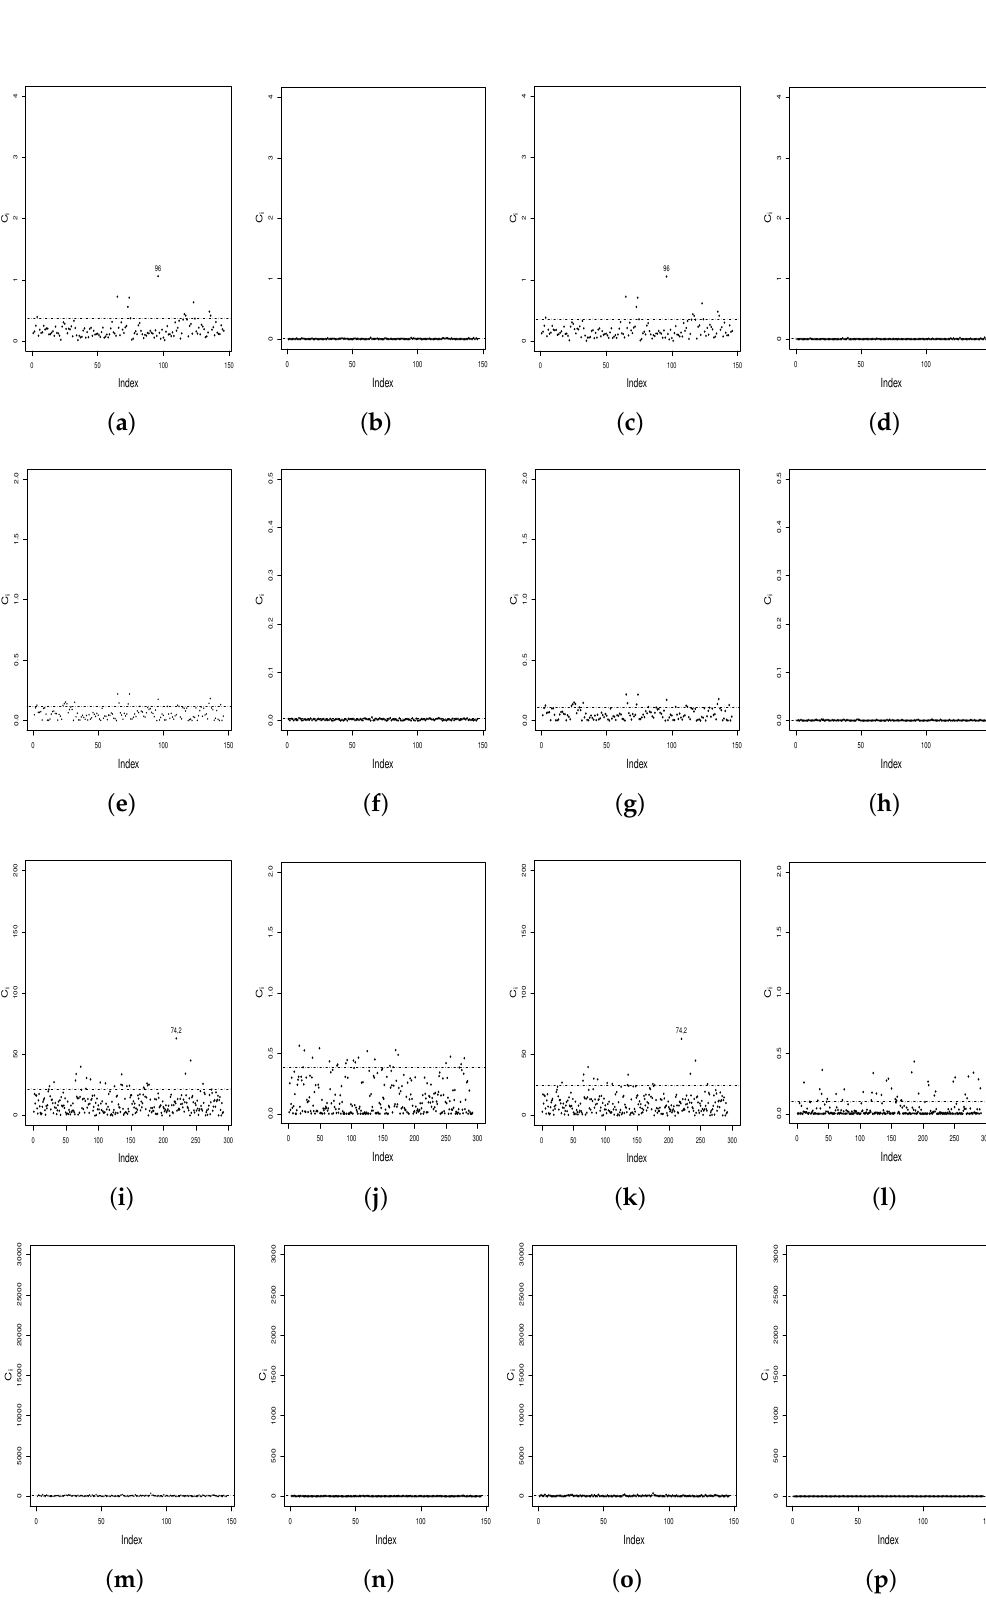
Figure 6. Total local influence index plots of the BS- t model for (cid:98) θ ( a , e , i , m ), (cid:98) α ( b , f , j , n ), (cid:98) β ( c , g , k , o ) and (cid:98) ρ ( d , h , l , p ) in (first row) case-weight perturbation; (second row) correlation matrix perturbation; (third row) response perturbation; and (fourth row) covariate perturbation, with Chilean PM